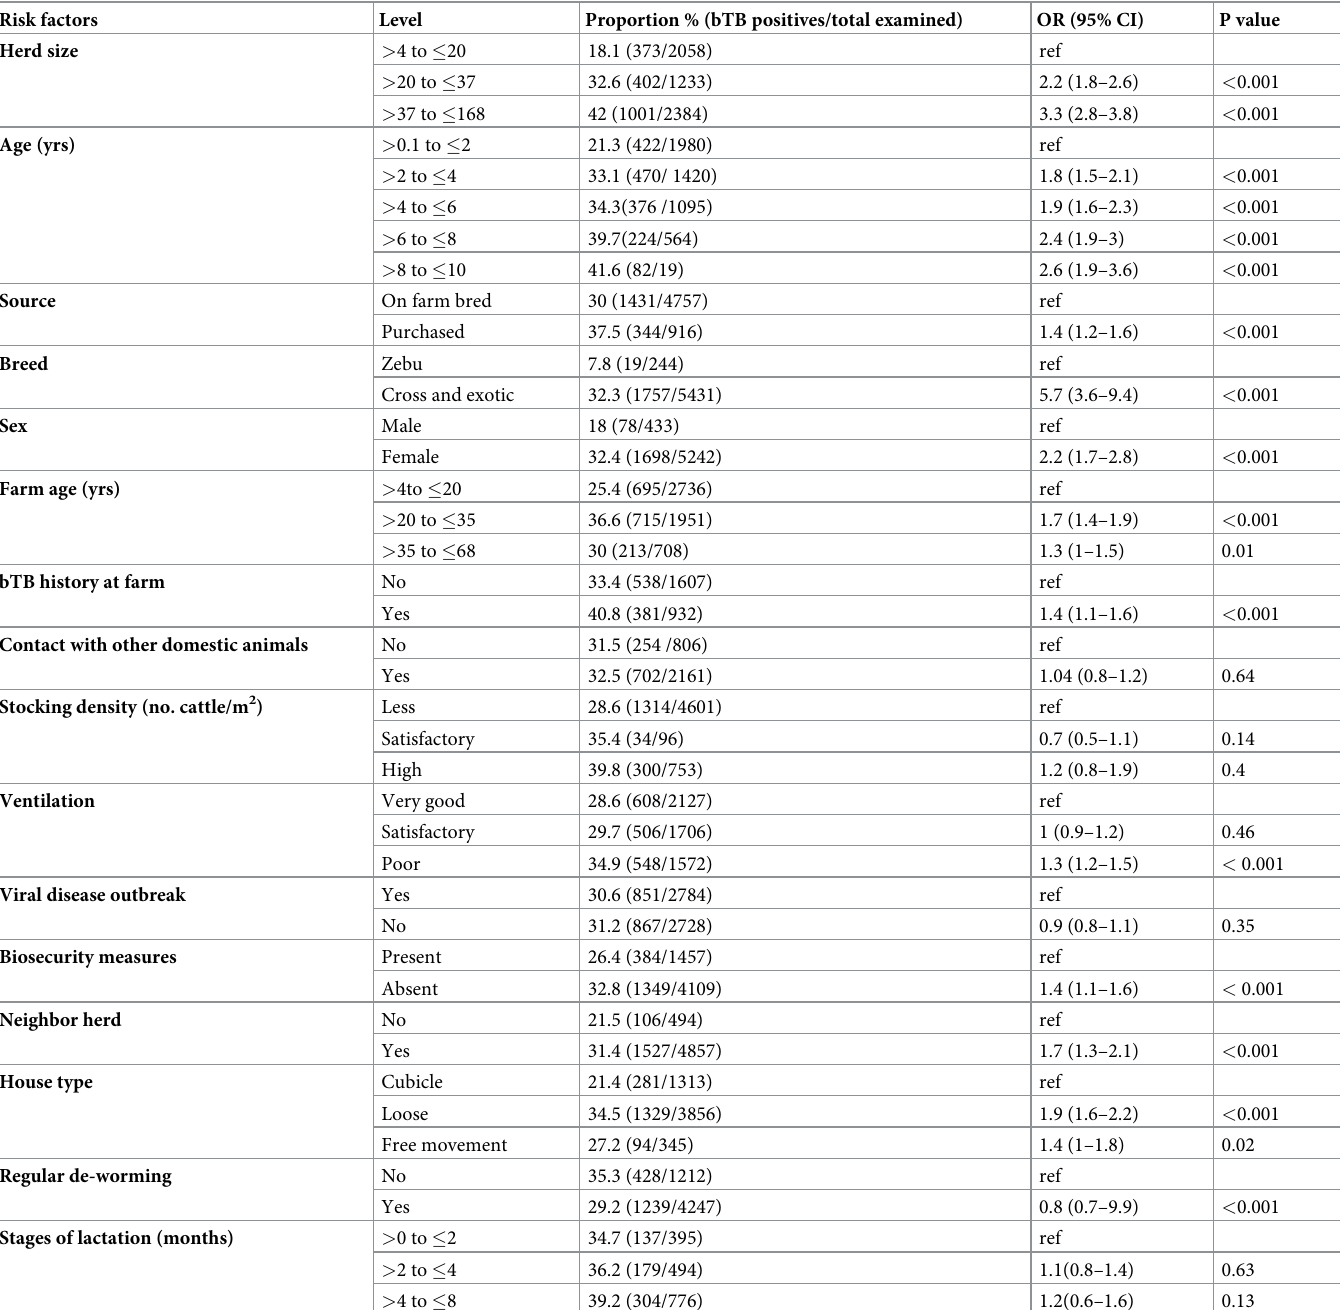
Table 4. Univariable analysis of potential risk factors for cattle tuberculin